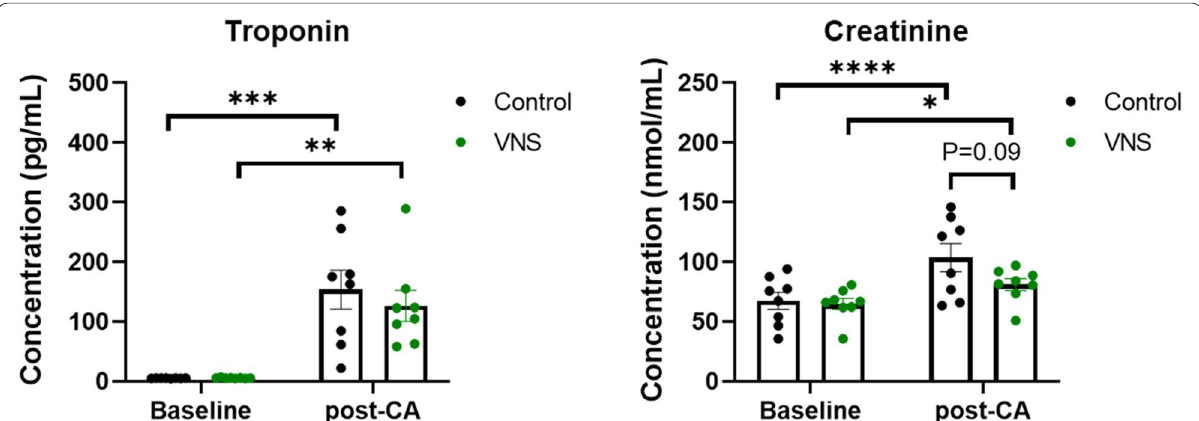
Fig. 6 Plasma troponin and creatinine levels after CA with and without VNS. A significant increase in plasma troponin levels was observed in both Control and VNS groups after CA as compared with their respective baseline levels ( P < 0.001 and P < 0.01). However, the increase was less severe after VNS. A significant increase in plasma creatinine levels was observed in both Control and VNS groups after CA as compared with their respective baseline levels ( P < 0.0001 and P < 0.05). The increase in creatine was less severe after tVNS and treatment with tVNS tended to show improvement in creatinine levels as compared with Control ( P 0.09). N 8 each. RM two-way ANOVA with Šídák’s multiple comparisons test. tVNS = = adjusted vagus nerve